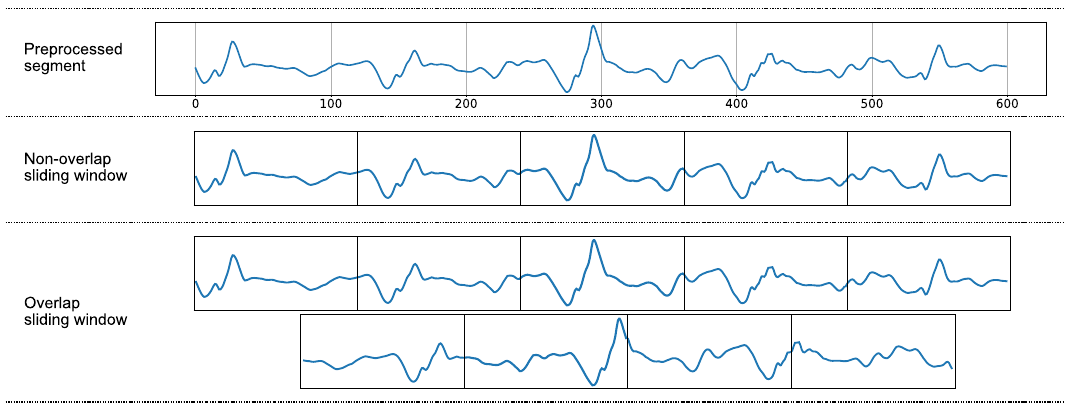
Figure 5. An overlapping sliding window creates more patterns than a non-overlapping sliding